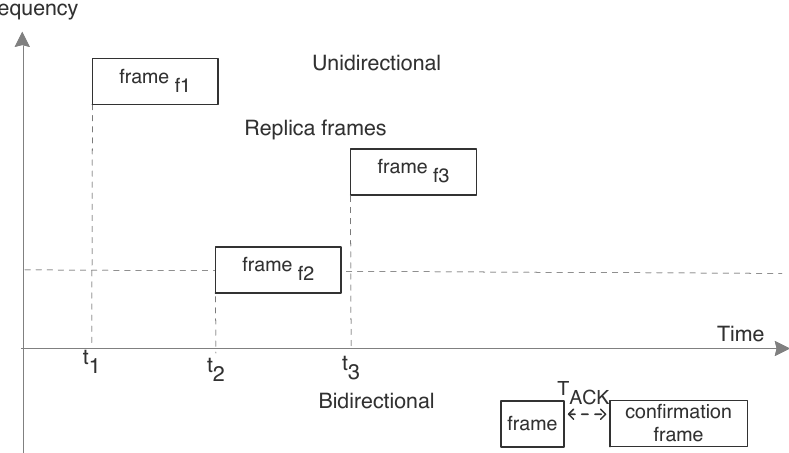
Figure 16. Sigfox unidirectional and bidirectional message transmission with replica messages at different frequency.